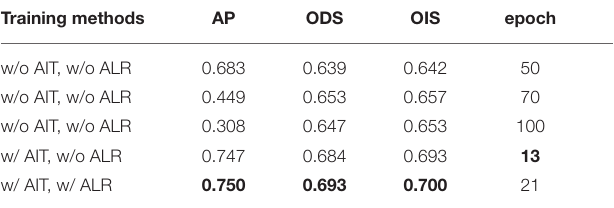
15, λ t 4, and n g 14. “w/o weight” is ω j = = =